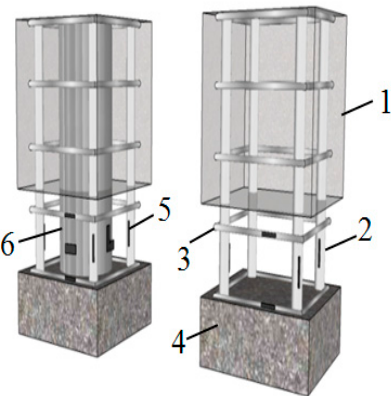
Figure 5. Gauge points arrangement (1. Concrete; 2. Longitudinal Reinforcement; 3. Stirrup form; 4.